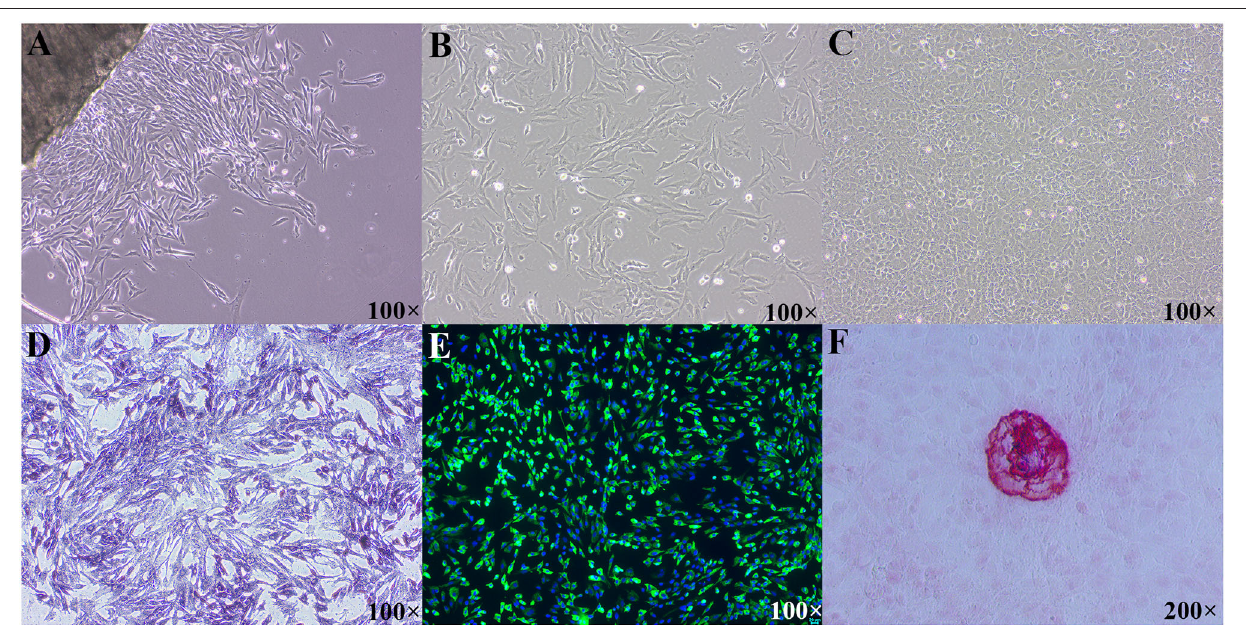
FIGURE 1 | Morphological features and identification of primary cultured tibial osteoblasts of broiler chicks. (A) Morphological image of P0 cells, day of 3 culture; (B) morphological image of P1 cells, day of 2 culture; (C) morphological image of P1 cells, day of 10 culture; (D) primary osteoblasts were positive in ALP straining; (E) immunofluorescence of COL1A1 in the primary tibial osteoblasts; (F) mineralized nodules were positive in ARS staining. ALP, alkaline phosphatase; COL1A1, collagen type I alpha 1; ARS, alizarin res S.